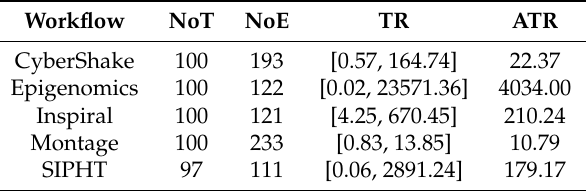
Figure 1. The structure of real-world scientific workflows. Table 4. The parameters of real-world scientific